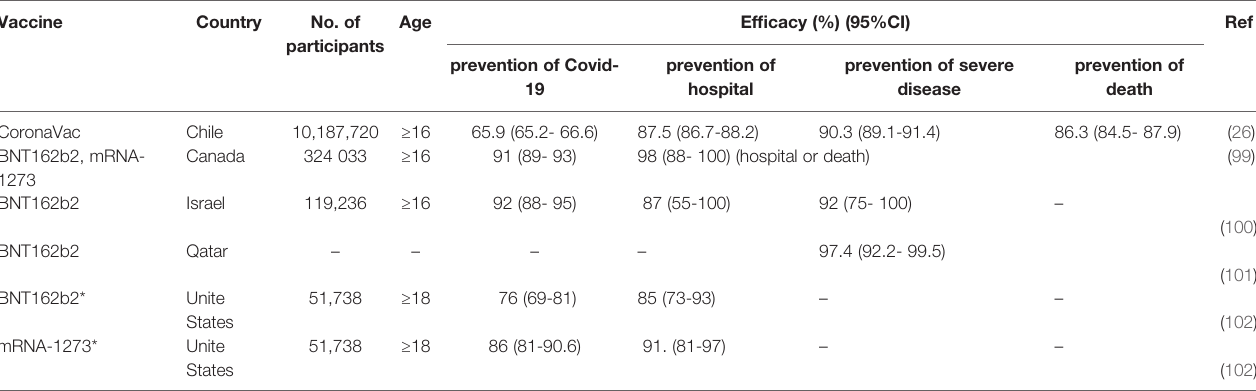
TABLE 4 | Ef fi cacy of COVID-19 vaccines in real word. Vaccine